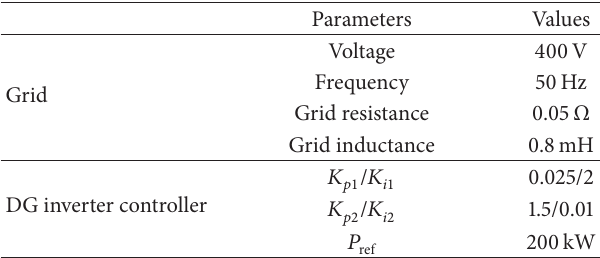
Table 1: Parameters of the study system.